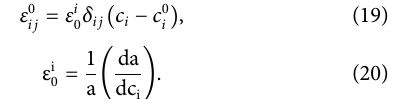
The elastic modulus of the matrix phase is different from that of the precipitated phase. The elastic modulus tensor C ijkl described by Eq. 24 considered the uneven effect of elasticity. The tensor of the elastic modulus depend on the concentration as the Eq. 24 can be shown. So the coef fi cient of the elastic modulus tensor can be derived form the formula of the concentration fi eld of it. ε el represents the elastic strain and is described in Eq. 25. ij